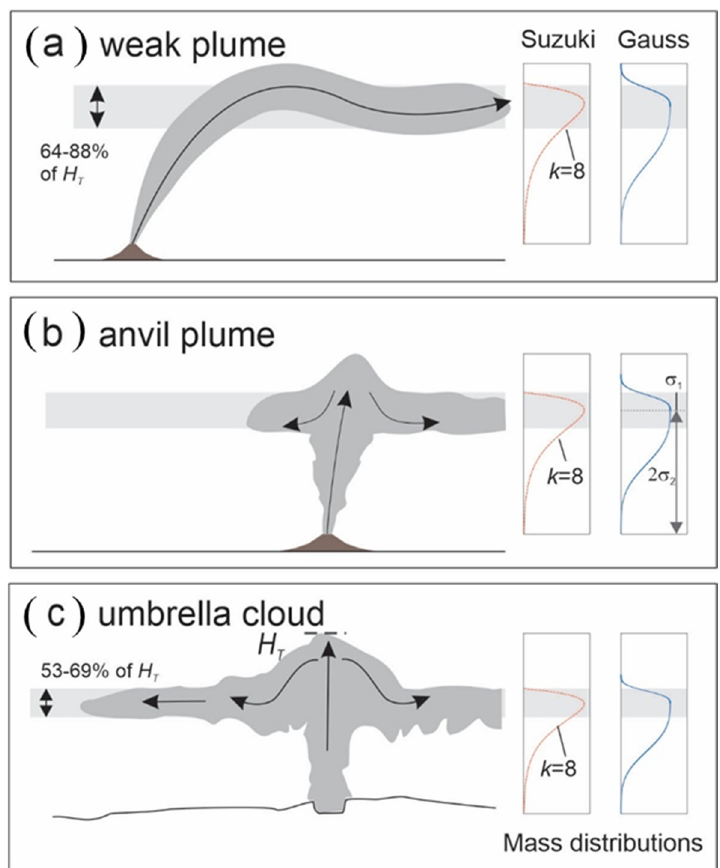
Figure 7. Two possible schemes for assigning vertical mass distribution to plumes of different size. Illustrated is ( a ) a weak plume, ( b ) an anvil plume, and ( c ) an umbrella-forming plume. Gray horizontal region in ( a ) represents the mean + /- standard deviation of neutral buoyancy heights for a weak, wind-driven plume calculated by one-dimensional plume models presented in Table 8 of Costa, et al. [53]. Gray bar in ( c ) represents the same range obtained by 1-D models for strong plumes (Table 12 of [53]). The gray bar in ( b ) represents a height range intermediate between ( a ) and ( c ). The cloud mass is assumed to be concentrated within these height ranges. On the right-hand side are possible vertical mass distributions with height. The red curves are Suzuki distributions with k = 8, extending from the vent to the top of the gray bar. Blue curves are an asymmetrical Gaussian distribution, with a maximum value in the center of the gray bar. Above that point, the standard error ( σ 1 ) is the bar’s half-height. Below the center, the standard error ( σ 2 ) is half the distance to the vent elevation.